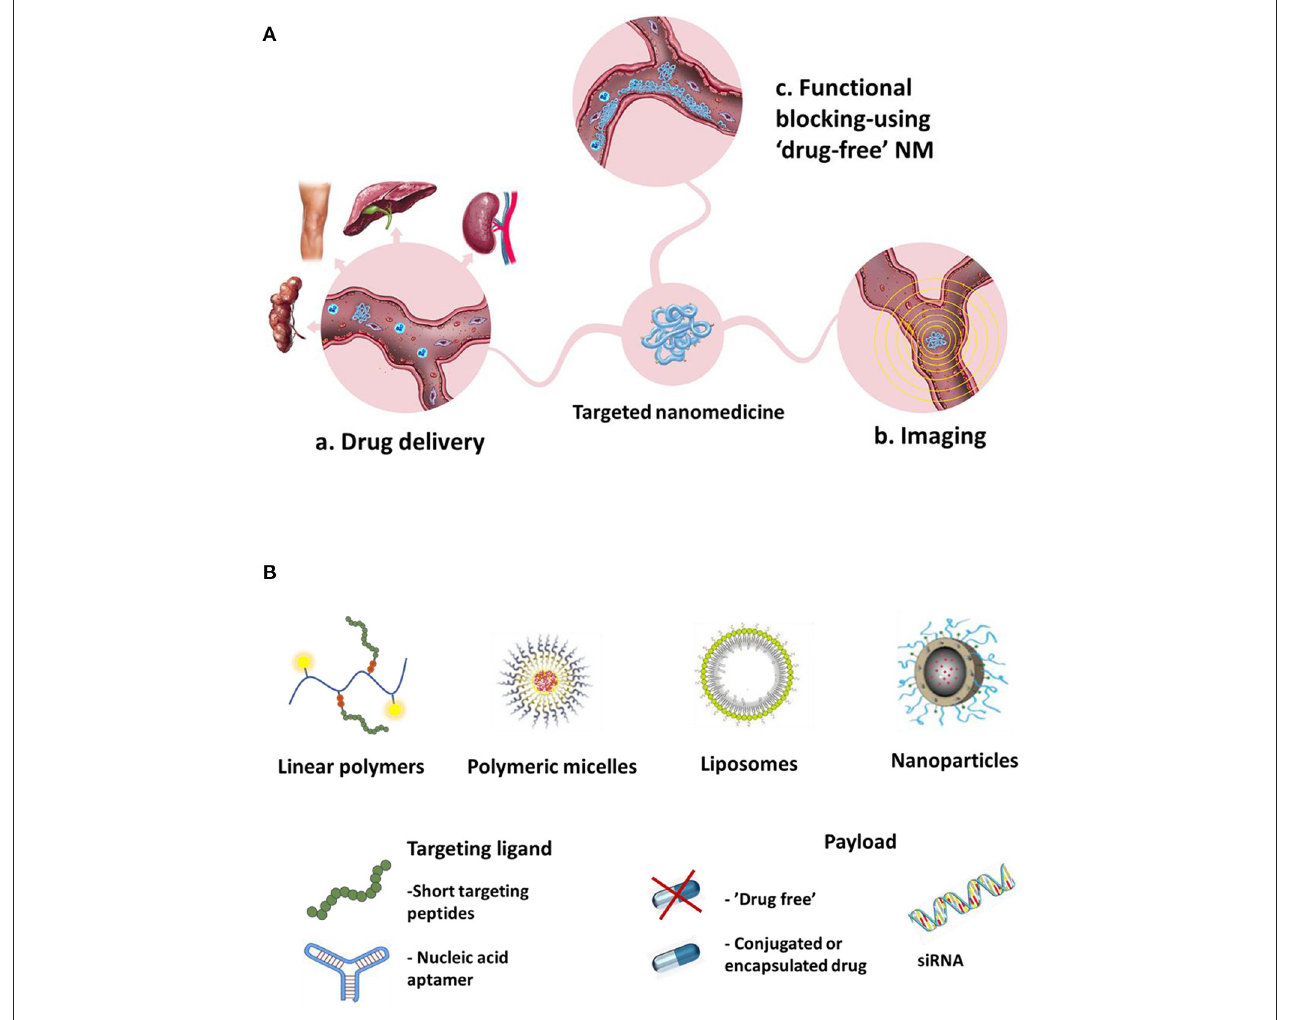
FIGURE 1 | Different proposed goals of CAMs-targeted NM (A) Different systems used for targeting CAMs, types of targeting ligands and payloads (B)